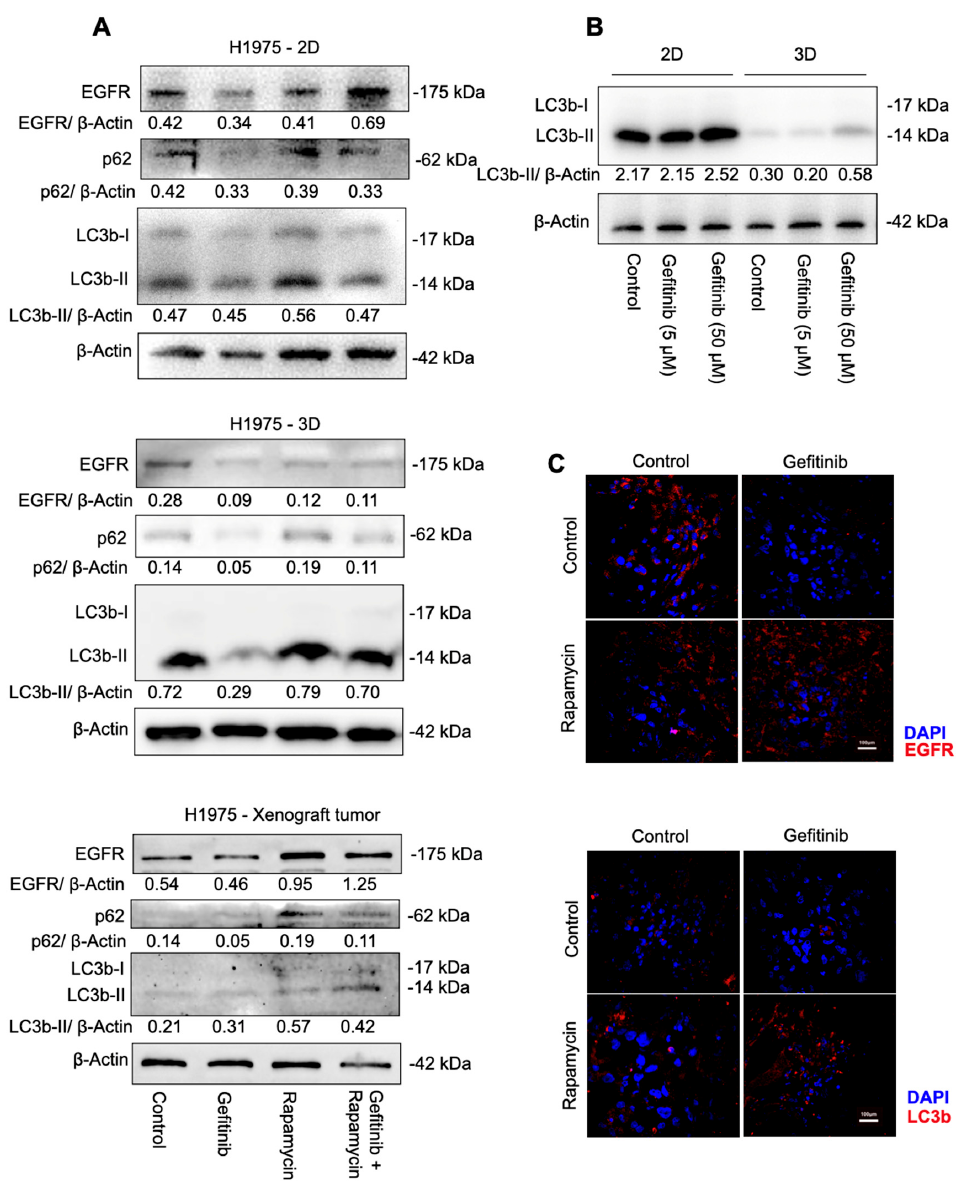
Figure 2. Autophagy activity in H1975 cells and xenografts under treatment with gefitinib, rapamy- cin, and their combination. ( A ) Immunoblotting and quantities analysis of p62, LC3b, and β− Actin protein expression in 2D cultures (gefitinib: 5 μ M; rapamycin: 10 μ M), 3D cultures (gefitinib: 5 μ M; β − Actin protein expression in 2D cultures (gefitinib: 5 µ M; rapamycin: 10 µ M), 3D cultures (gefi- rapamycin: 20 μ M), and xenograft tumors (gefitinib: 150 mg/kg; rapamycin: 2 mg/kg). ( B ) Immunob- lotting analysis of LC3b and β− Actin protein expression in 2D cultures, 3D cultures. ( C ) Immuno- tinib: 5 µ M; rapamycin: 20 µ M), and xenograft tumors (gefitinib: 150 mg/kg; rapamycin: 2